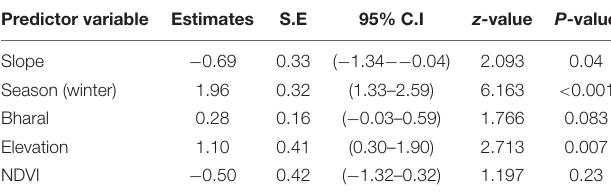
TABLE 6 | Summary of fixed effect estimates of the average model for supported models ( (cid:49) AICc values < 2; wolf ∼ slope + season + bharal + elevation, wolf ∼ elevation + slope + season, wolf ∼ season + elevation + slope + NDVI) of the woolly wolf in the Nelang valley of the Gangotri National Park, Uttarakhand, India. The p -values < 0.05 indicate that the estimate is